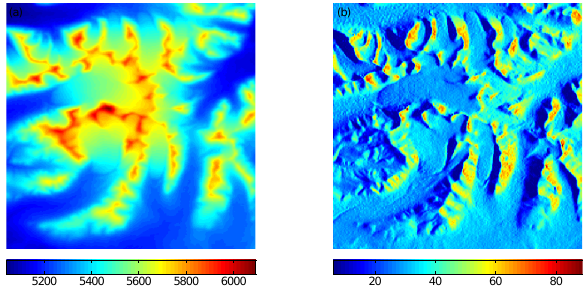
Figure 2. (a) DEM of test site; (b) the local incidence